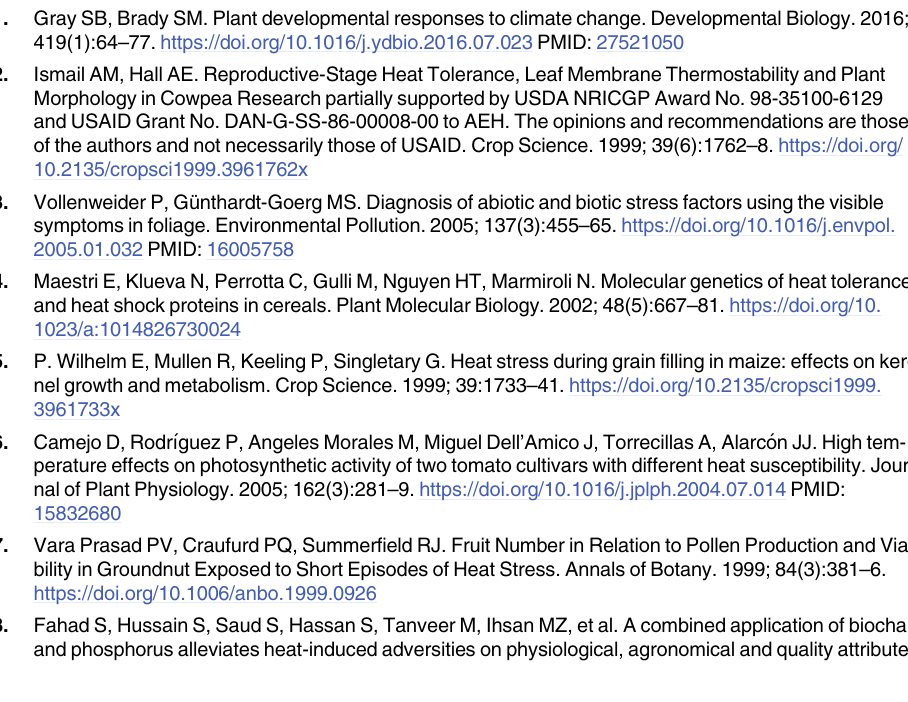
S7 Table. Olive oil composition in both climate regions during 2016 and